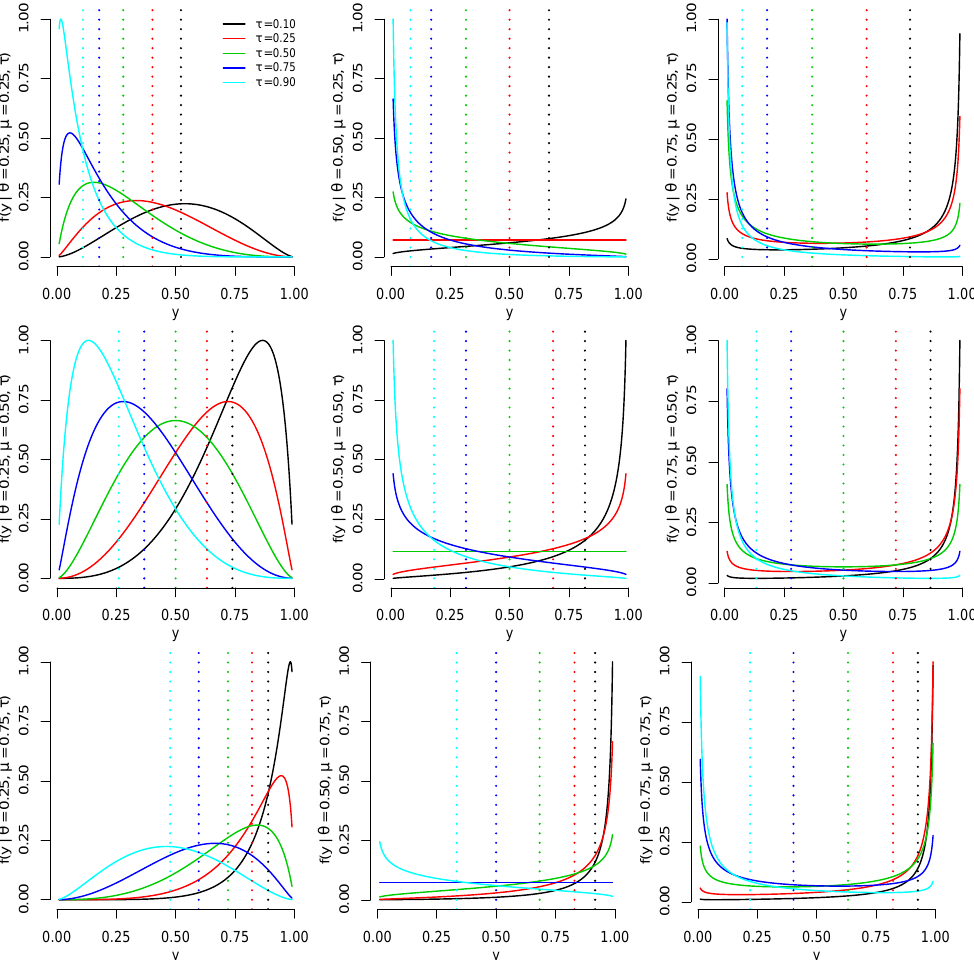
Figure 2. Plots of the PDF stated in (1) with quantile parameterization for different combinations of θ , µ , and τ